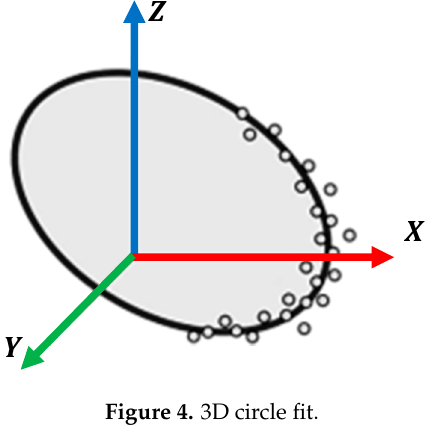
Figure 4. 3D circle fit.